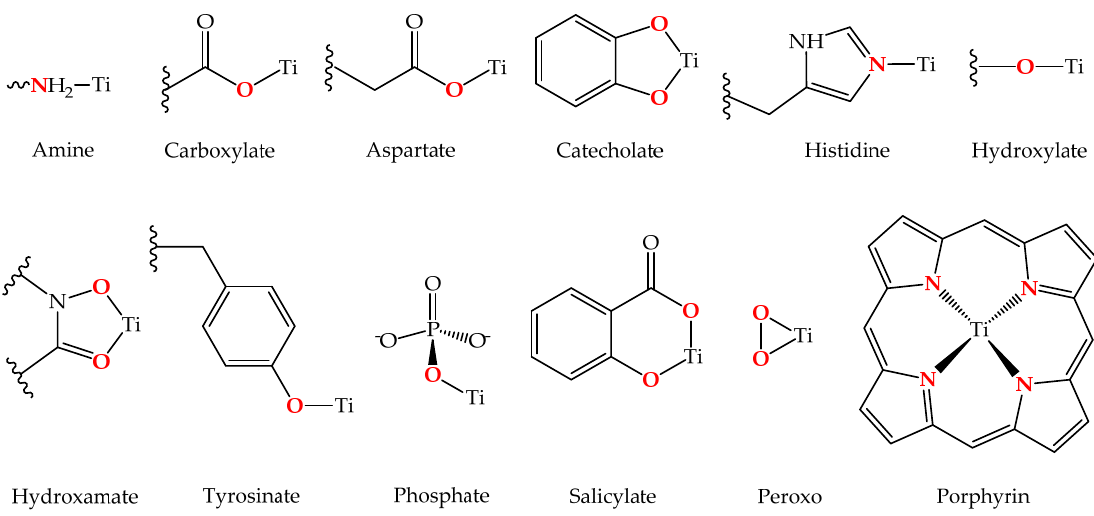
Figure 2. Typical Ti(IV) binding moieties of endogenous ligands with some representative